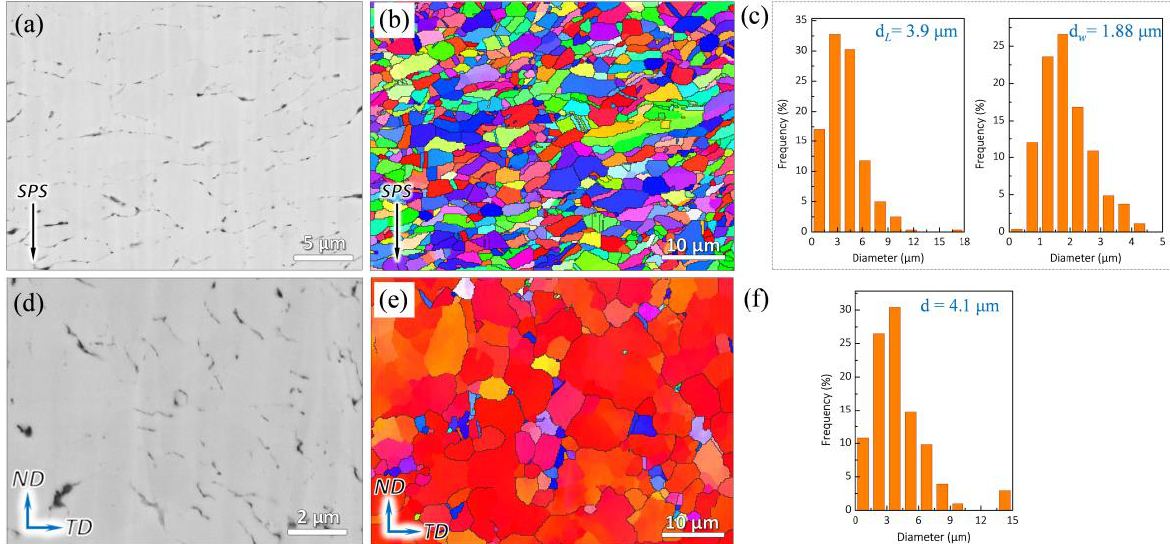
Figure 2. SEM-BSE images of ( a ) as-sintered and ( d ) as-extruded composites. IPF maps of ( b ) as- sintered and ( e ) as-extruded composites, the arrows in ( a , b ) show the direction of pressure of SPS. ( c ) Grain size of the as-sintered composite. The width and length of grains are expressed as d W and d L , respectively. ( f ) Grain size of the as-extruded composite (magnifications for ( a , d ) are ×10,000 and ×20,000, respectively).